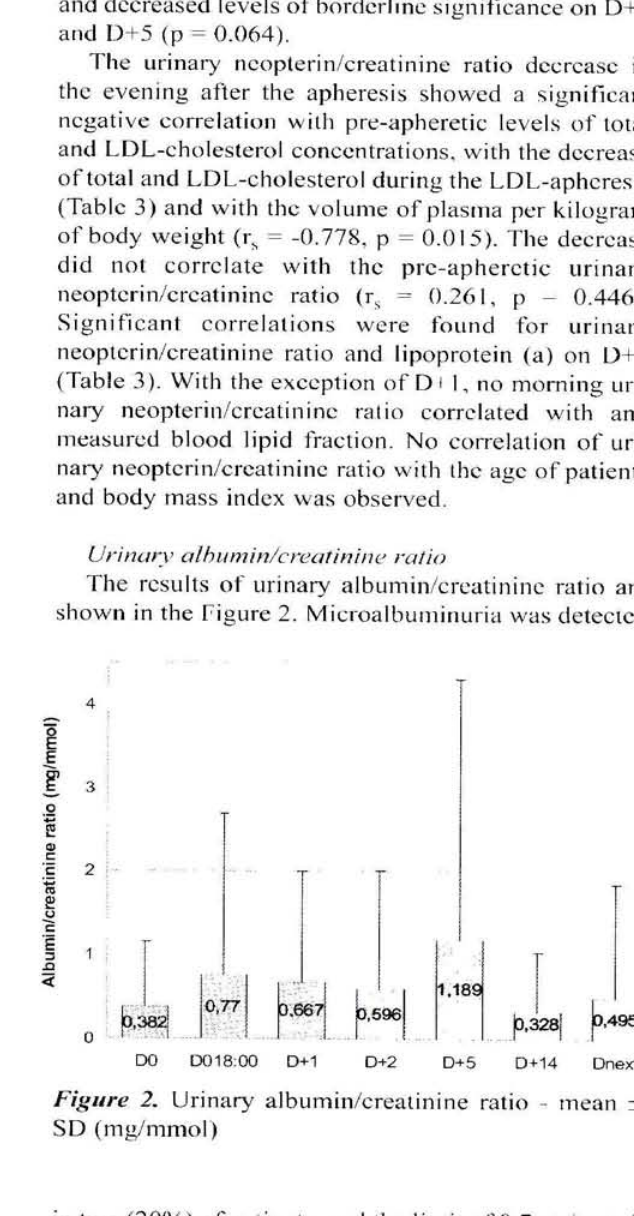
in two (20%) of patients, and the limit of 0.7mg/mmol. thought to be important in assessment of